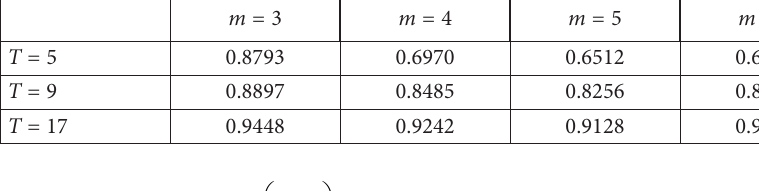
Table 1. The values of consistency thresholds